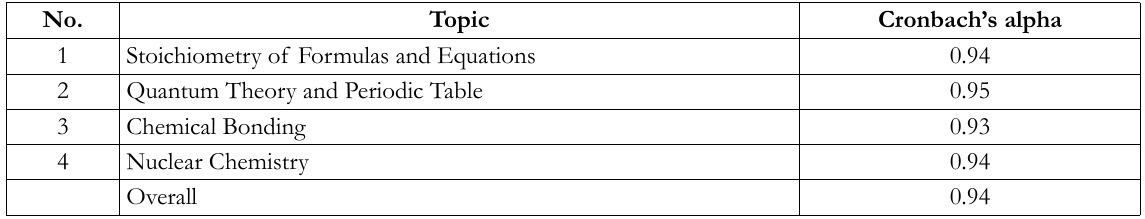
Table 6. Cronbach's alpha for each topic in the e-content module (Hamid, 2020)